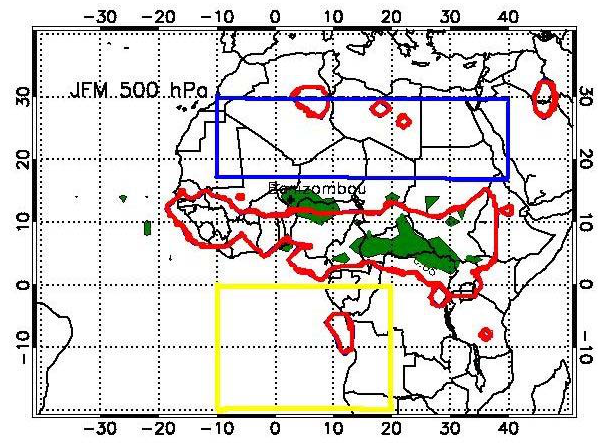
Fig. 9. Number of trajectories per day averaged in January– February–March (JFM) 2006. Trajectories are binned in a 2 ◦ latitude-longitude grid. Red contours indicate the average position 4 per day averaged in January-February-March (JFM) 2006. Trajectories are binned in a 2° latitude-longitude grid. Fig.9. Number of trajectories Green contours represent the average position 4 to 6 days before arrival at 500 hPa over Banizoumbou. Red contours indicates areas where forest to 6 days before arrival at 500hPa over Banizoumbou. Red contours fires observed from AATSR occurs. Fire pixel are taken into account if their number is larger than 10 in the three-months period. Areas defined as indicate areas where forest fires observed from AATSR occur. Fire ‘Desert ‘ and ‘Ocean’ are indicated by blue and yellow rectangles respectively. pixel have been taken into account whenever their number is larger than 10 in the three months period Areas defined as “Desert” and “Ocean” are indicated by blue and yellow rectangles,